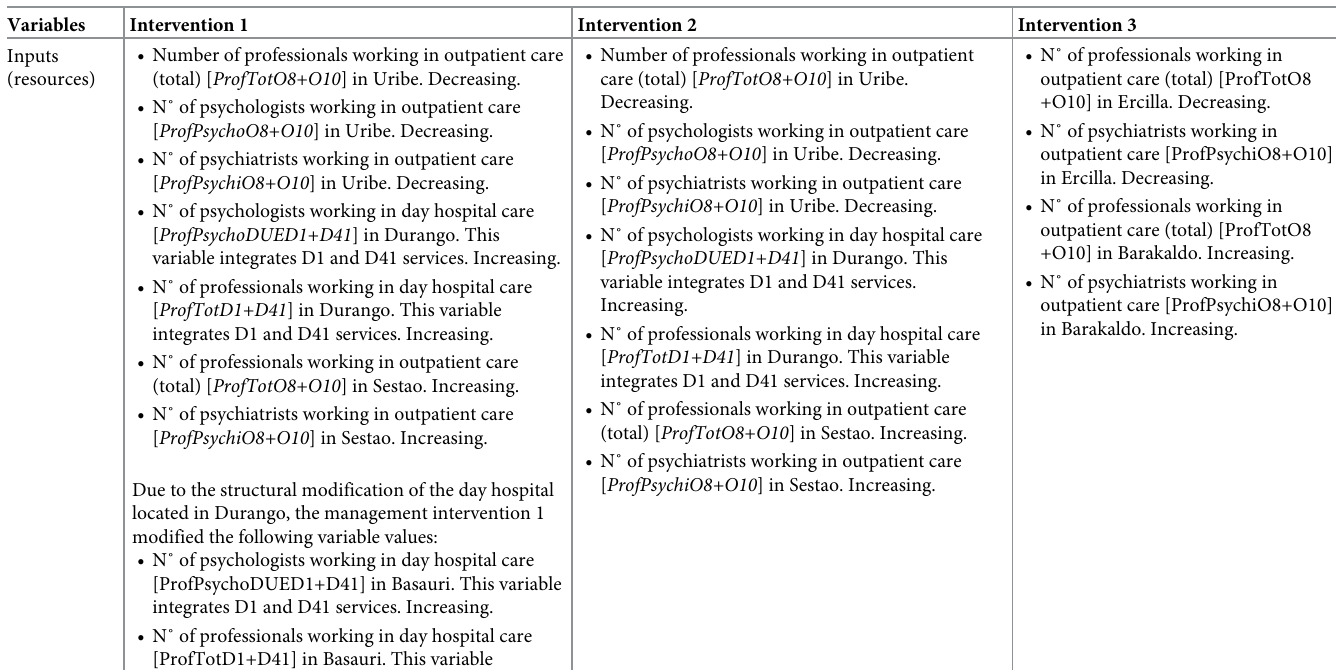
Table 2. Variables affected in the